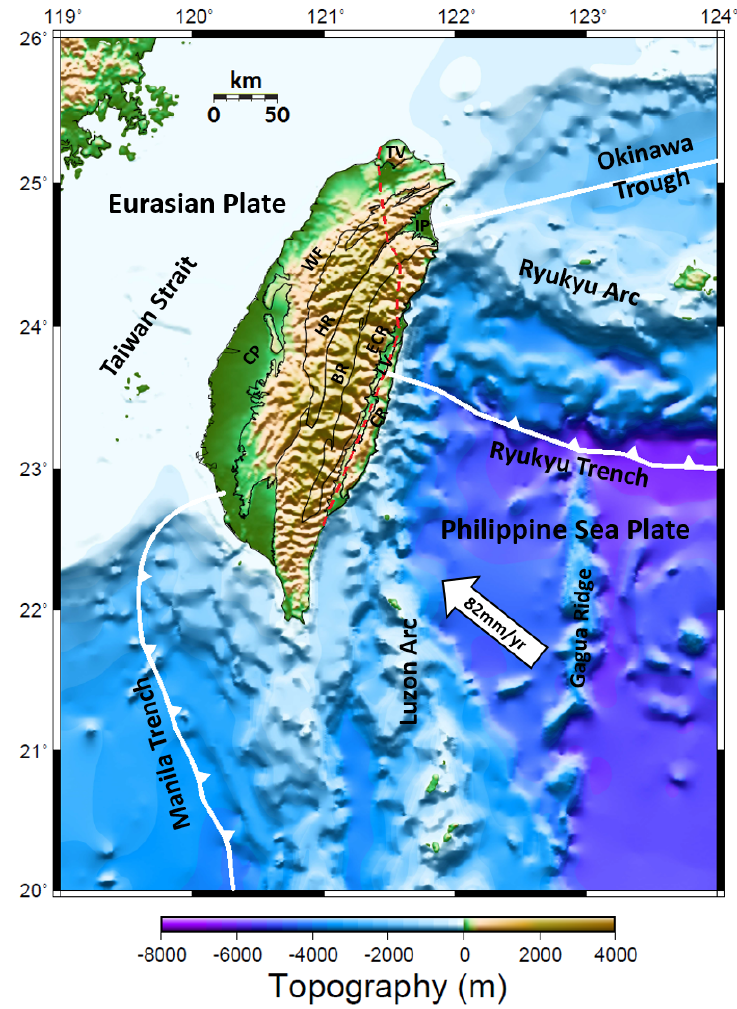
Figure 1. Plate configuration in the vicinity of Taiwan. The Philippine Sea Plate is moving northwestward with a rate of 82 mm/year and colliding with the Eurasian Plate. The red dotted line is the western edge of the Philippine Sea Plate, which is modified from Wu et al. [8]. IP = Ilan Plain, TV = Tatun volcano, LV = Longitudinal Valley, CP = Coastal Plain, HR = Hsueshan Range, WF = Western Foothills, BR = Backbone Range (or Western Central Mountain Range), ECR = Eastern Central Mountain Range and CR = Coastal Range.